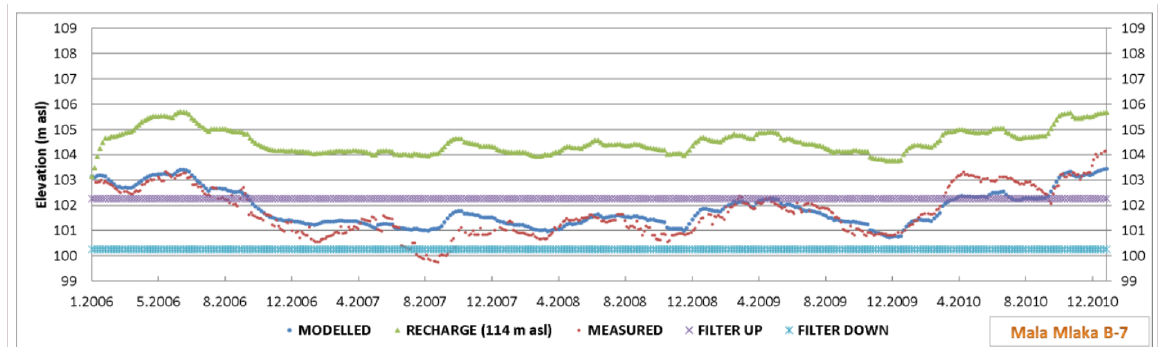
Figure 17. Influence of the MAR variant with a water level of 114 m a.s.l. on well B-7 of the Mala Mlaka water pumping station.